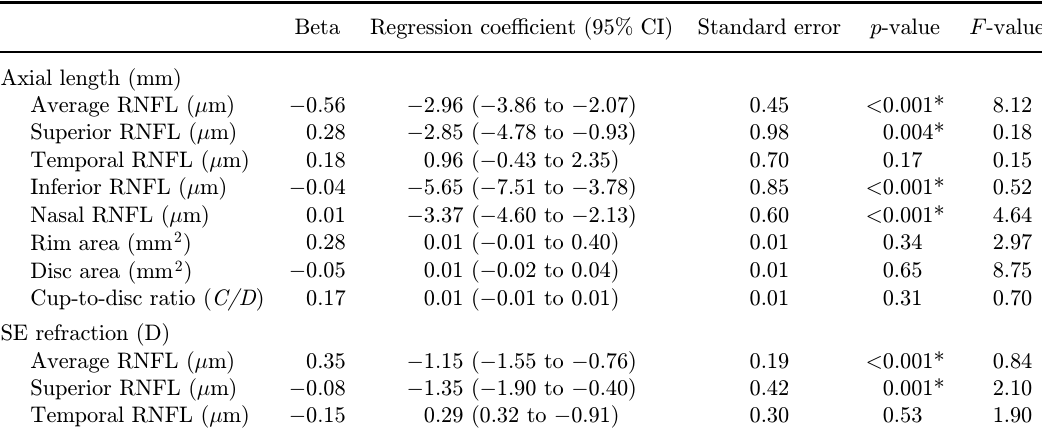
Table 4. Results of multivariate-mixed model analysis of the association between AL, SE and age